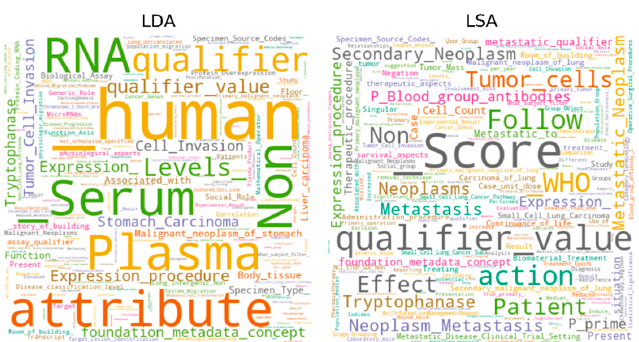
Figure 7. Word cloud of the top-1 topics on the AIM hallmark.